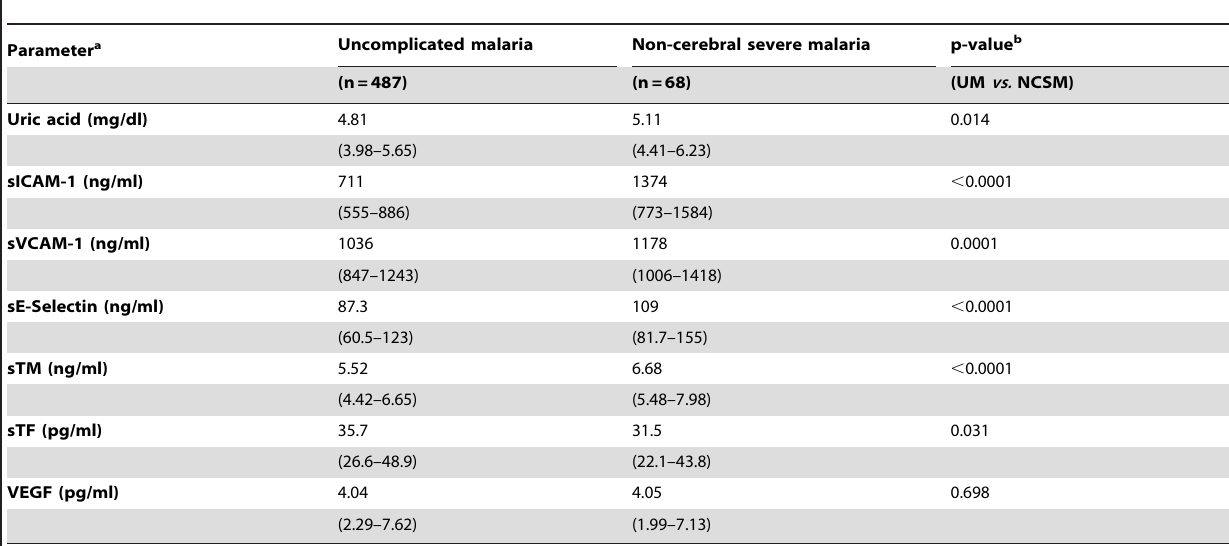
Table 3. Plasma levels of UA and biomarkers of endothelial activation/damage, stratified by disease severity. Parameter a